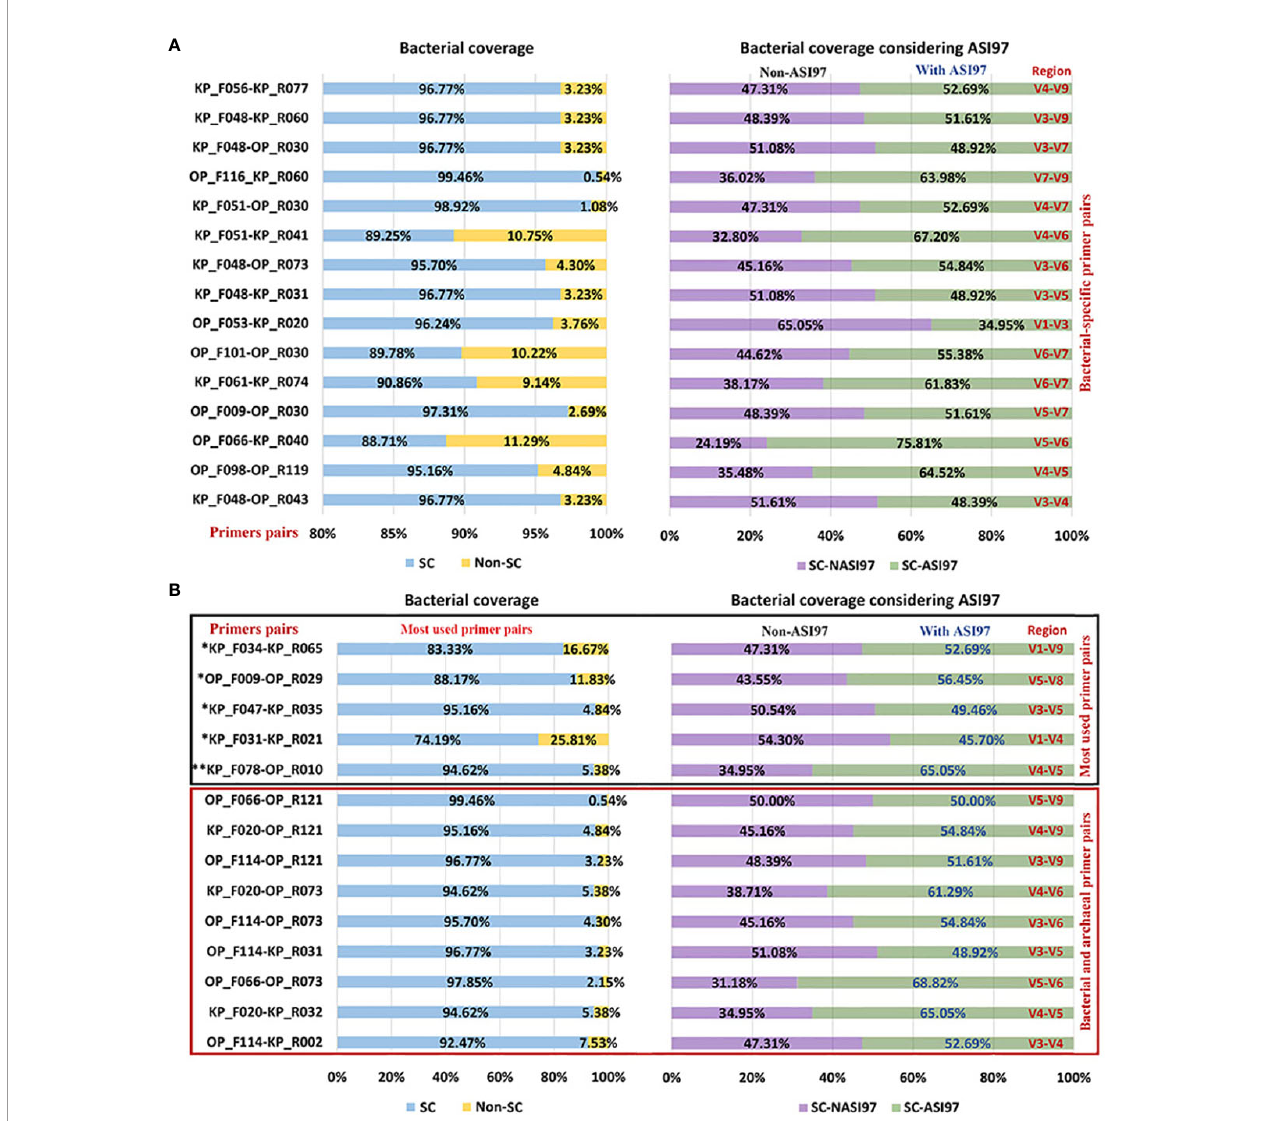
FIGURE 4 | Percentages of coverage and coverage considering the species with in-silico amplicon similarity values ≥ 97% of the primer pairs evaluated against the oral bacteria genomes. (A) Percentages were obtained by the selected bacterial-speci fi c primer pairs. (B) Percentages were obtained by the selected bacterial and archaeal primer pairs and the primer pairs used the most in the oral microbiome literature. Among the most commonly used primer pairs in the literature, those marked with an * are bacterial-speci fi c and those with ** target both bacterial and archaea. ASI97, in-silico amplicon similarity values ≥ 97%; F, forward; KP, Klindworth primer; Non-SC, non-coverage of species; OP, oral primer; R, reverse; SC, species coverage; SC-ASI97, species coverage with in-silico amplicon similarity values ≥ 97%; SC-NASI97, species coverage with no in-silico amplicon similarity values ≥